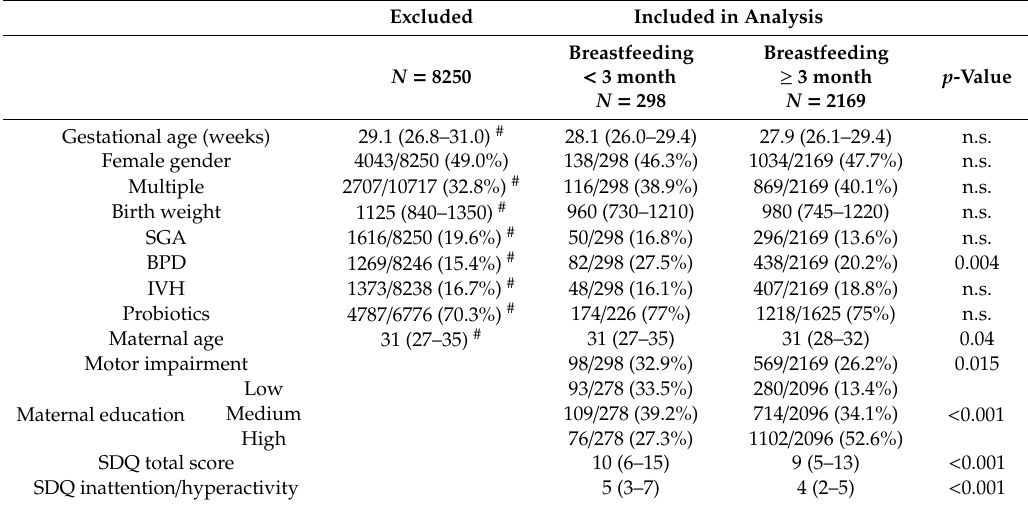
Table 1. Characteristics of very-low-birth-weight children (VLBWI) included after birth and those with follow-up included in the